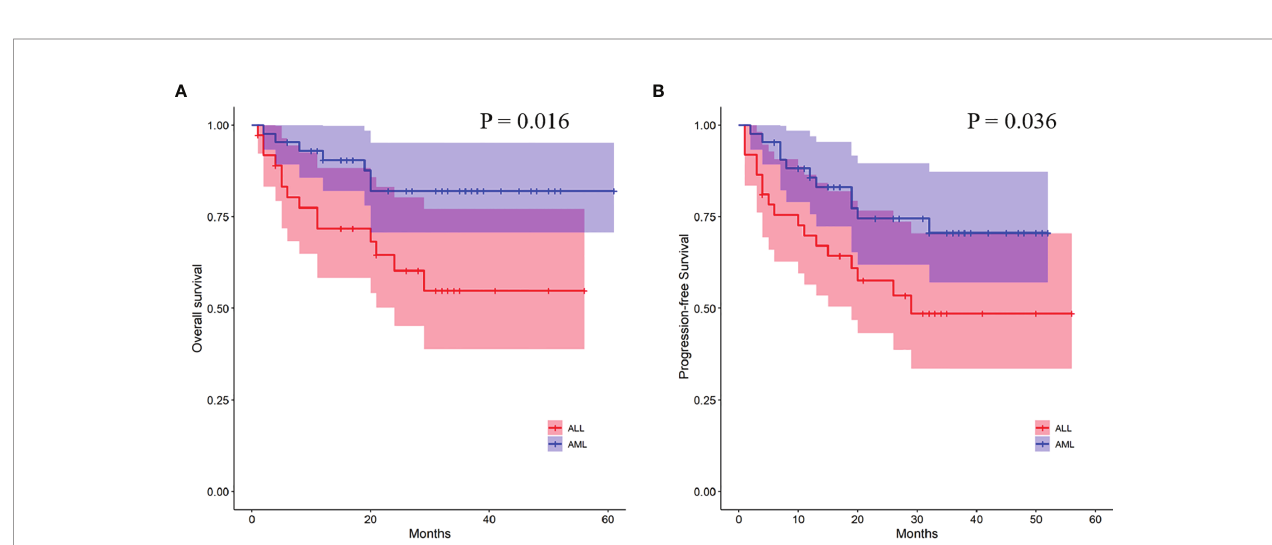
FIGURE 4 | Transplant outcomes between AML and ALL patients in the EBV+/CMV − subgroup. (A) OS between AML and ALL patients in the EBV+/CMV − subgroup. (B) PFS between AML and ALL patients in the EBV+/CMV −